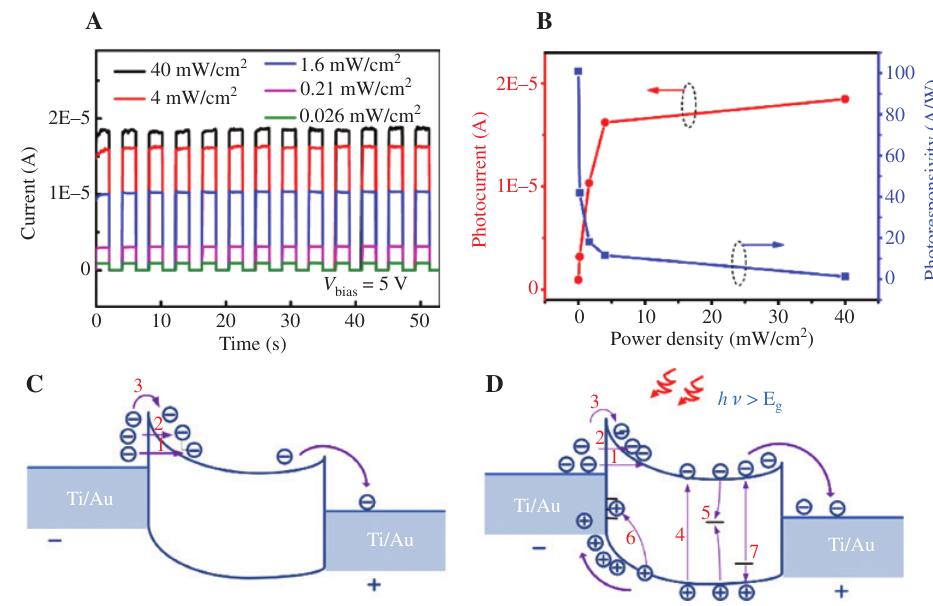
Figure 6: (A) Photocurrent as a function of time with different laser power density modulated. (B) Laser power dependence of the photoresponsivity and photocurrent. Schematic energy band diagrams of the few-layer MoSe illumination